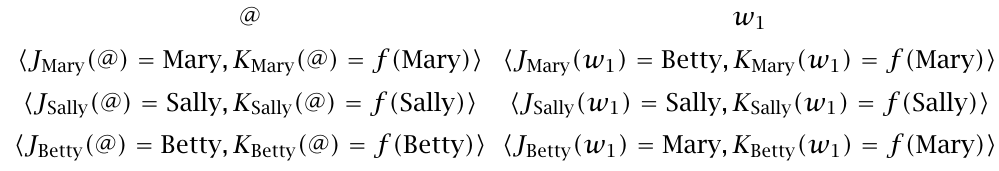
Illustration of “extensional acquaintance”